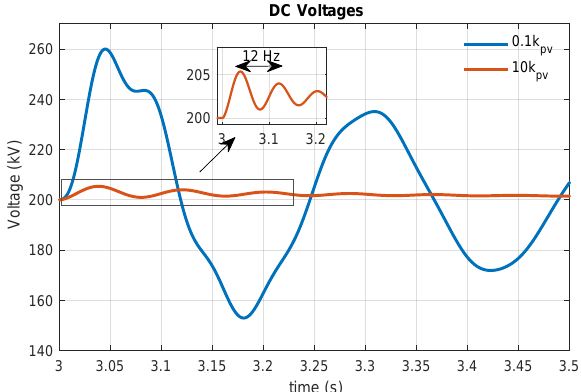
Figure 23. Time domain plot of grid side DC voltage to sensitivity of outer-loop proportional gain, k pv .